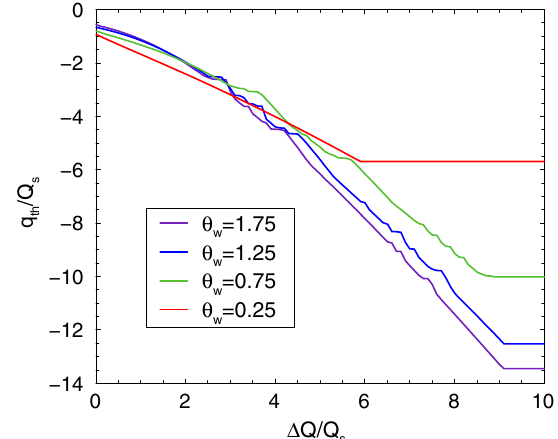
FIG. 9. TMCI threshold of a short square wake against a SC tune shift. The length of the wake is θ w , and the bunch length is 2. 9 (55 modes) is used; the The approximation with n max ¼ horizontal lines mark the end of the applicability area.